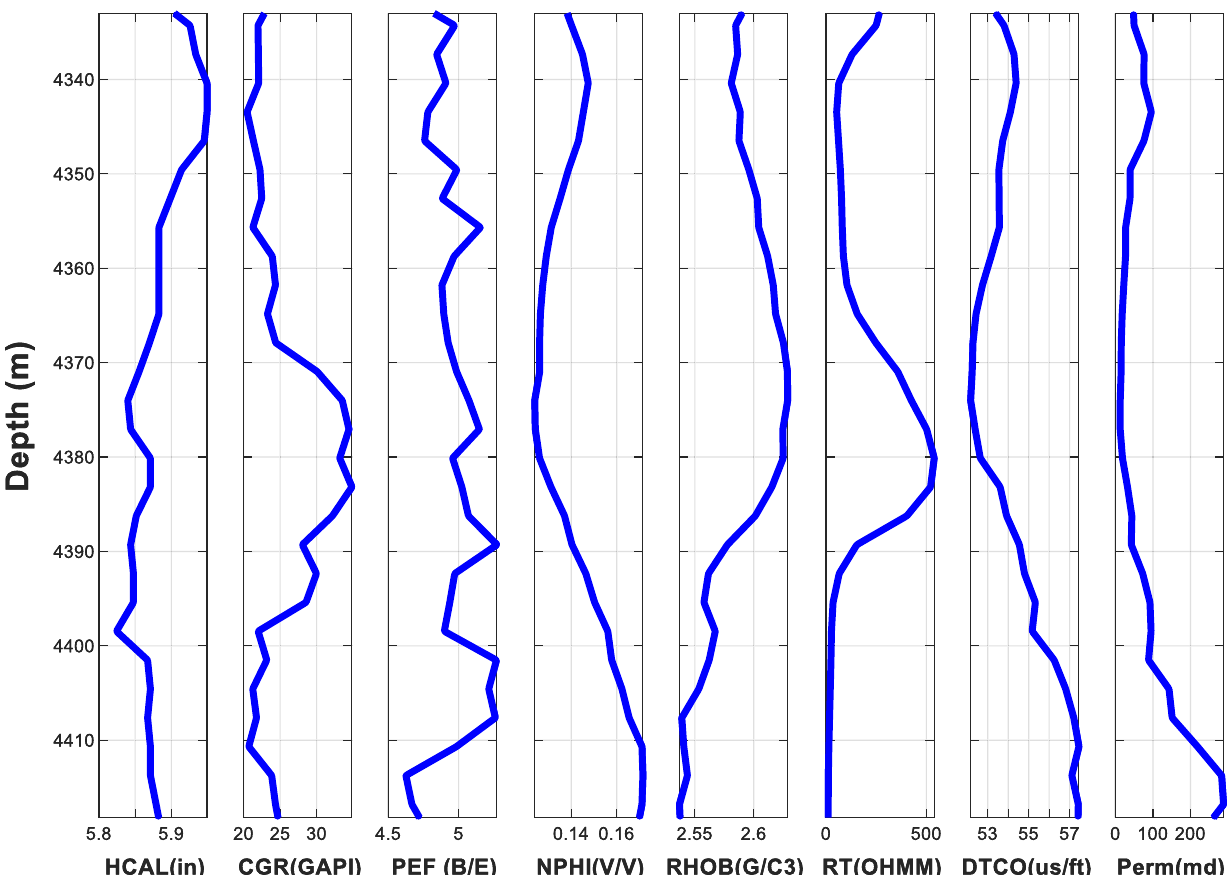
Fig. 4 Variations of petrophysical log readings and permeability over the studied depth interval at the studied well B